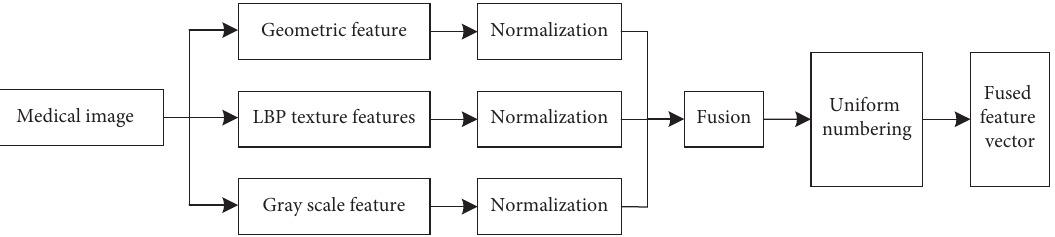
Figure 6: Feature fusion process.